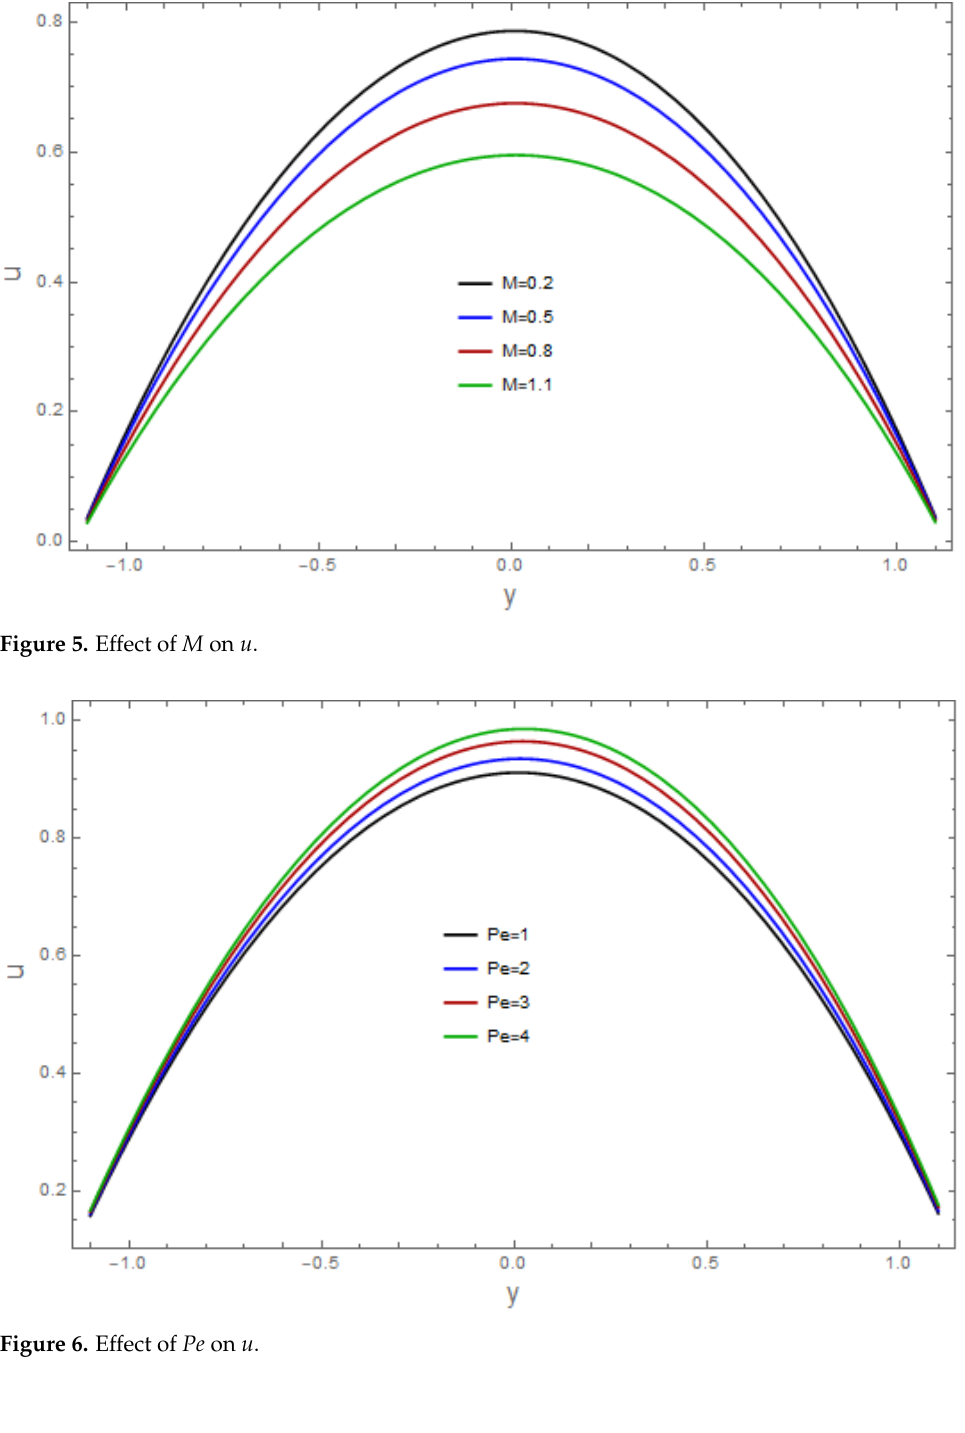
Figure 4. Effect of 𝐺𝑐 on 𝑢 .